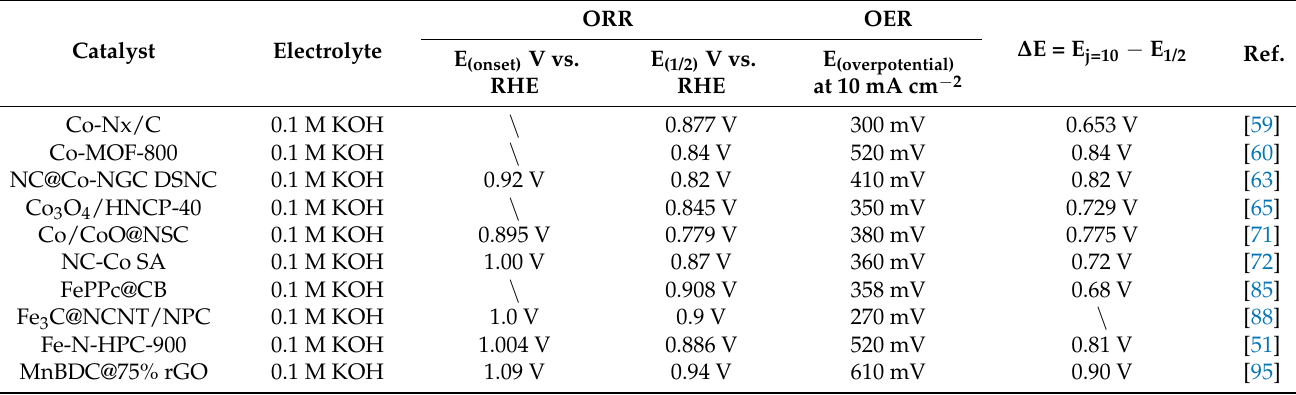
Table 1. Summary of ORR/OER performance of MOF-based non-precious metal